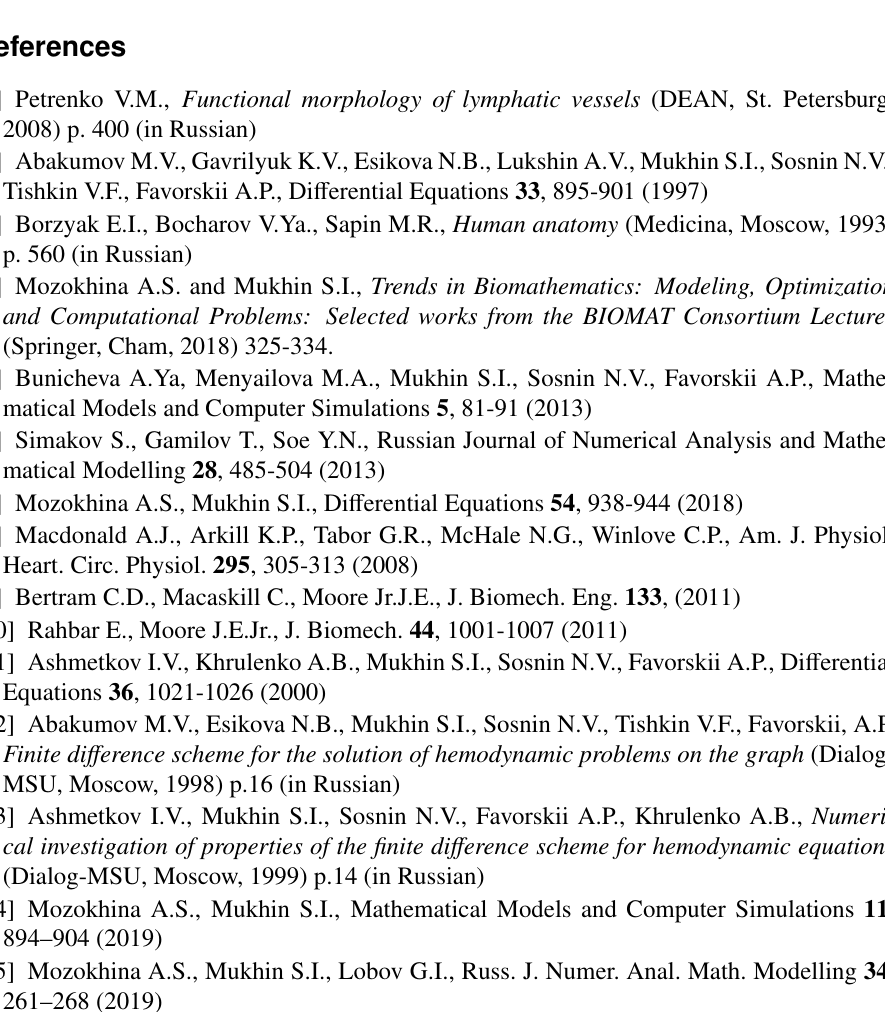
gradient. It means that active contractions can be the main force propagating lymph in the LS at least